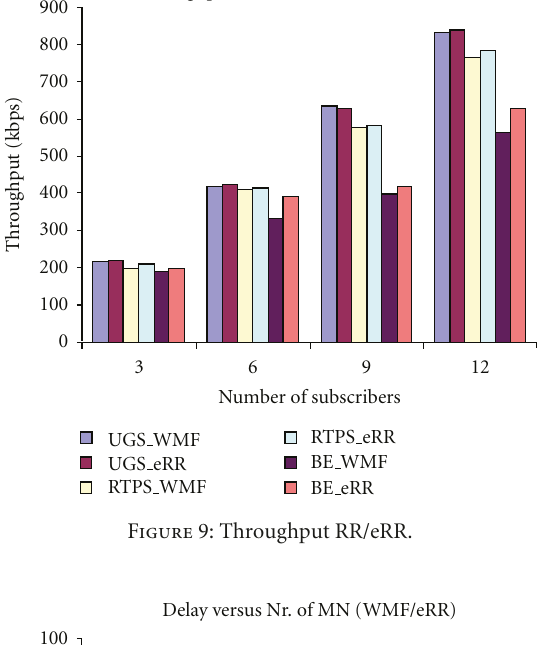
Figure 9: Throughput RR/eRR.